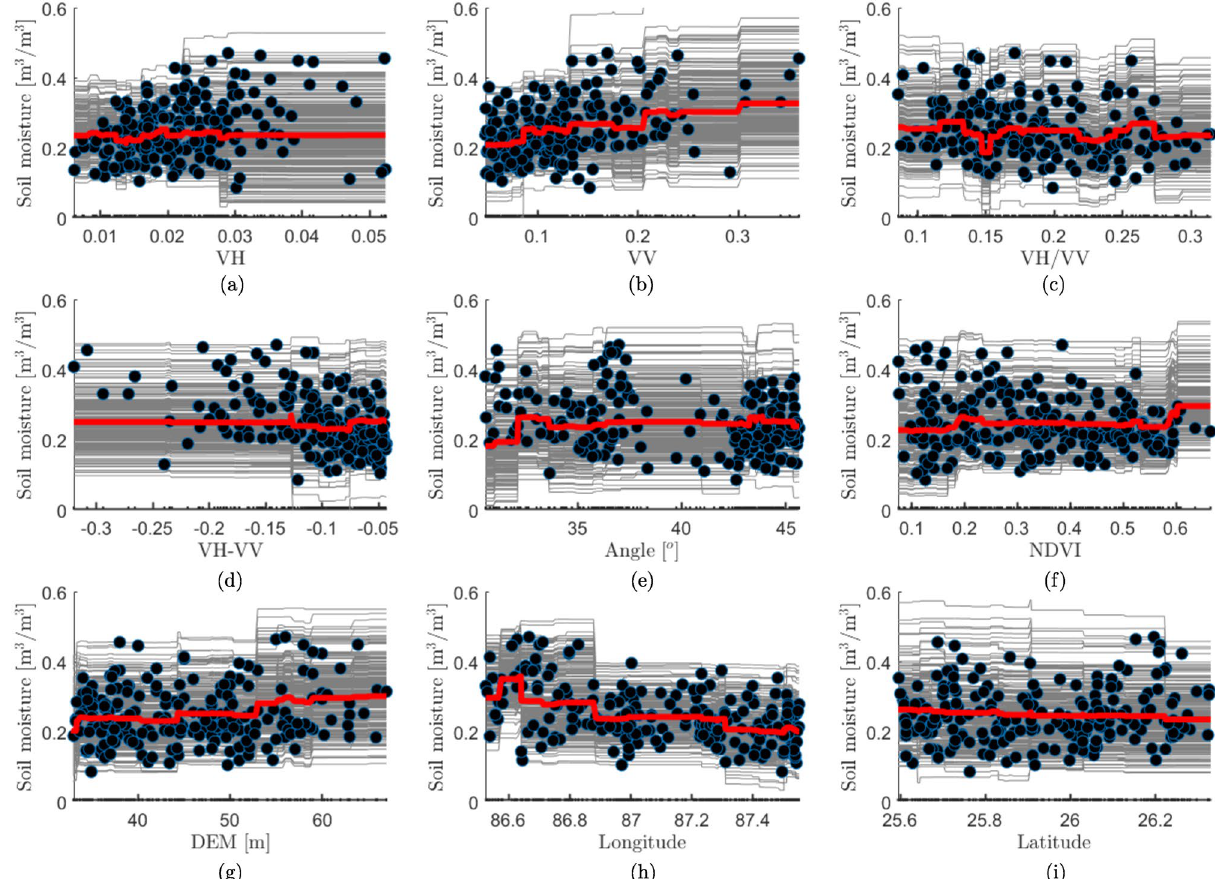
Figure 7. Feature sensitivity analysis using PDP (red line) and ICE curve (gray lines). The circles in black represent the